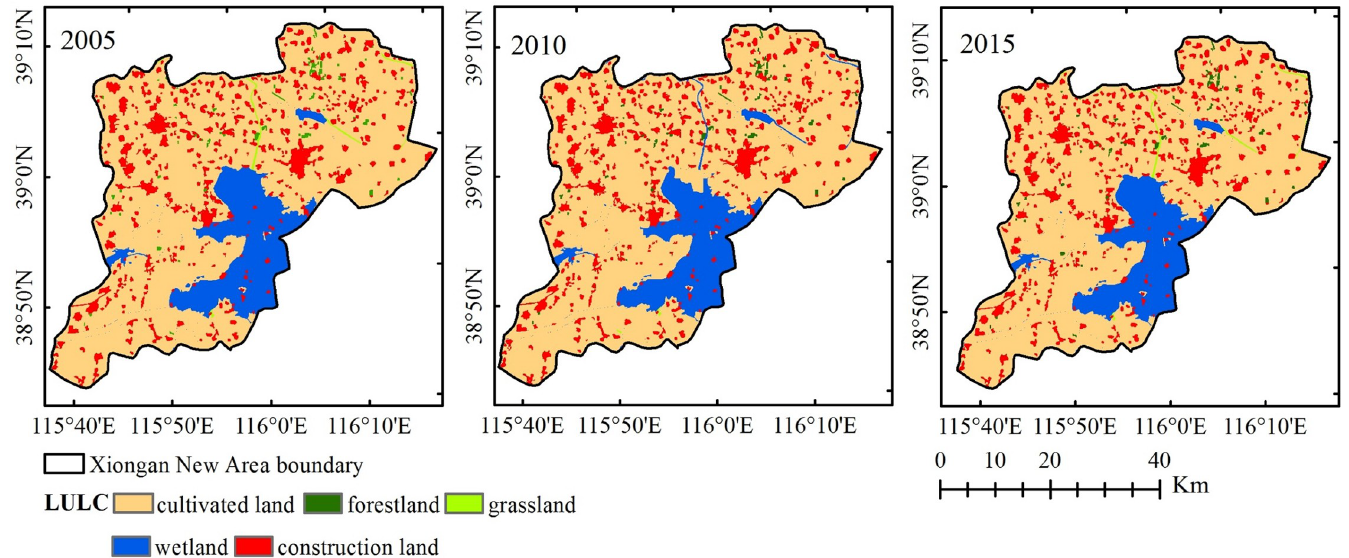
Fig 2. Land cover map for 2005, 2010 and 2015 in the Xiongan New